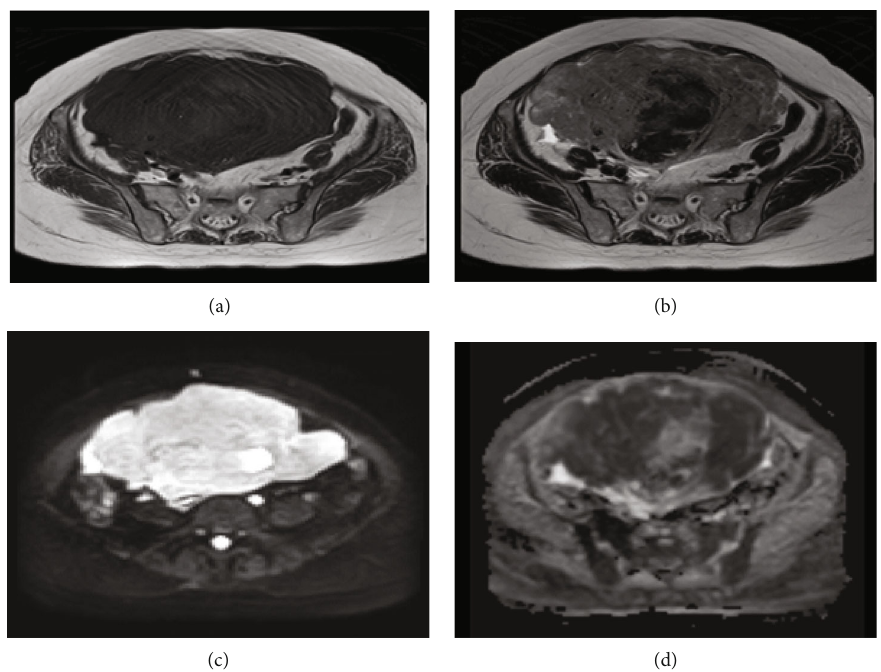
Figure 2: Pelvic MRI imaging: (a) T1-enhanced images; (b) T2-enhanced images; (c) ADC map b = 1000 ; (d) di ff usion-weighted images. The tumor demonstrated moderate to strong T2-enhanced images; marked di ff usion-weighted enhancement was noted on the tumor that had almost completely invaded the uterine myometrium.